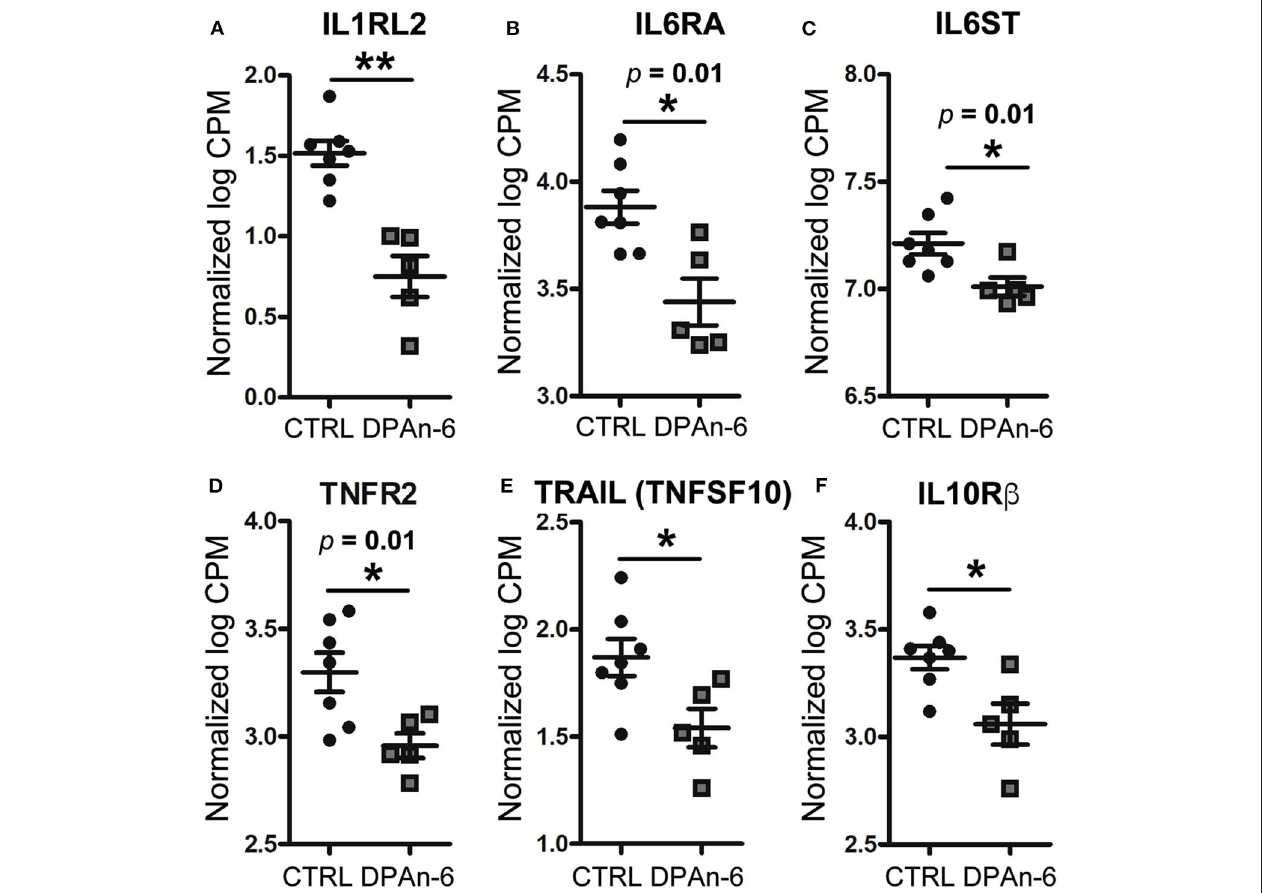
FIGURE 2 | DPAn-6 reduced mRNA expression of proinflammatory cytokine and cytokine receptors in the brain of aged E4FAD mice. In RNA-Seq data, (A) DPAn-6 reduced interleukin-1 receptor-like 2 (ILRL2, p < 0.01). (B) DPAn-6 reduced interleukin 6 receptor alpha (IL6RA, p = 0.01). (C) DPAn-6 reduced IL6 signal transducer (IL6ST, p = 0.01). (D) DPAn-6 reduced tumor necrosis factor receptor 2 (TNFR2, p = 0.01). (E) DPAn-6 reduced tumor necrosis factor-related apoptosis-inducing ligand (TRAIL, also known as tumor necrosis factor superfamily, member 10 (TNFSF10), p < 0.05)). (F) DPAn-6 decreased IL-10 receptor beta (IL-10Rß, p < 0.05). The RNA-Seq data were normalized by Count Per Million (CPM) and presented as Log2 expression. Data represent the mean ± SEM. Significance was determined using an unpaired, two-tailed Student’s t -test, * p < 0.05, and ** p <